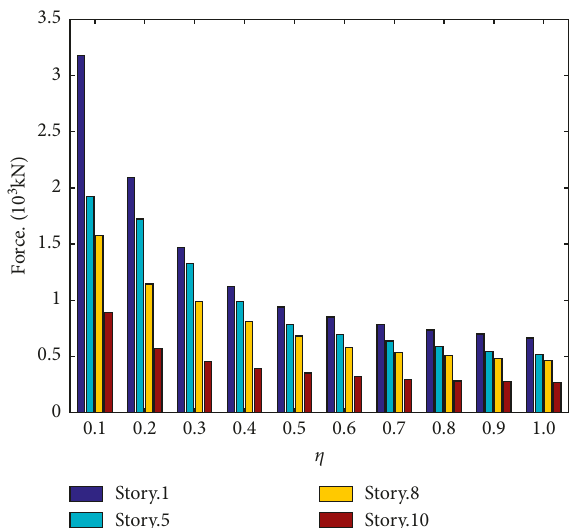
Figure 22: Statistics of maximum damping force of dampers under the action of the 0.51g El Centro